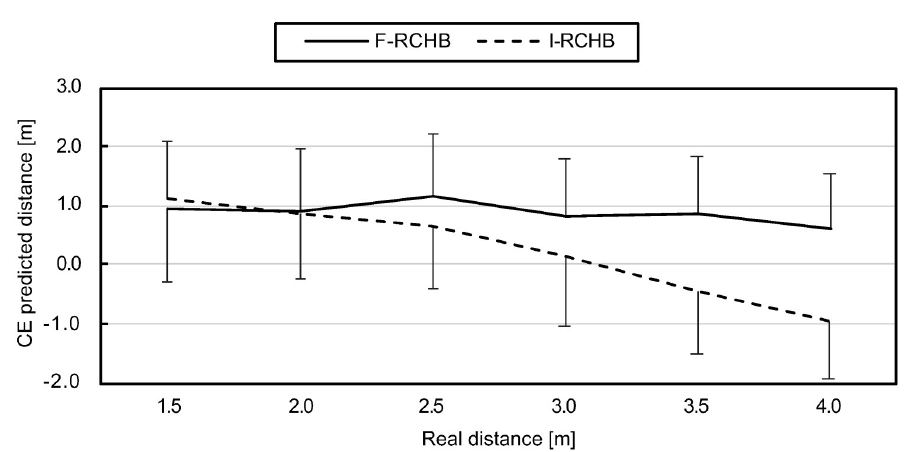
Fig 10. Constant error. Mean and standard deviation of the constant error of predicted putting distance under full (F-RCHB) and incomplete (I-RCHB) vision condition.